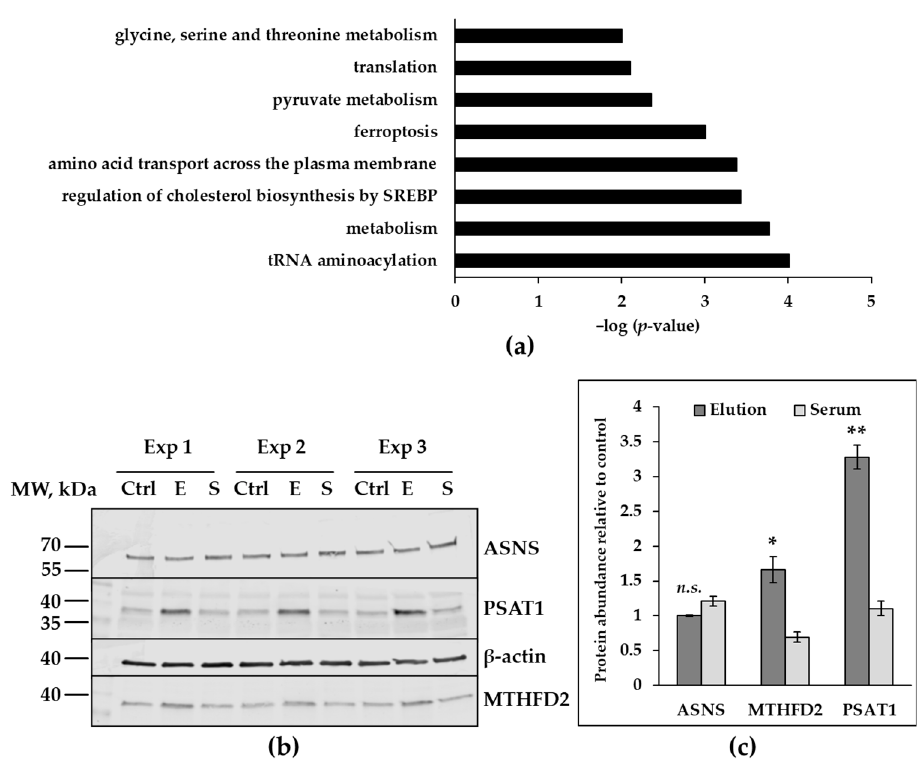
Figure 3. Targets involved into metabolism regulators, up-regulated in HAECs after 24 h treatment. ( a ) Biological process categories overrepresented in 201 up-regulated genes in HAECs after 24 h treatment with eluted proteins (array data, n = 2). Significance generated with ConsensusPathDB- human (release 34, [26]) is presented on the x-axis as negative logarithmized p -value. ( b ) Validation of up-regulated protein targets with immunoblotting. Proteins of interest were detected in cell lysates obtained from untreated HAECs (Ctrl), HAECs treated with 0.125 µg/mL of elution (E), 0.125 µg/mL of serum-control (S). Samples from three independent experiments are marked as Exp 1, Exp 2, Exp 3. ( c ) Signal intensities from protein targets were normalized to signal intensities from β -actin, signals from treated cells are expressed as percent from untreated control. The data are presented as mean values with ± SEM (* p ≤ 0.05; ** p ≤ 0.001; n.s.—no significant difference compared to untreated control). Abbreviations: ASNS − asparagine aminotransferase, PSAT1–phosphoserine